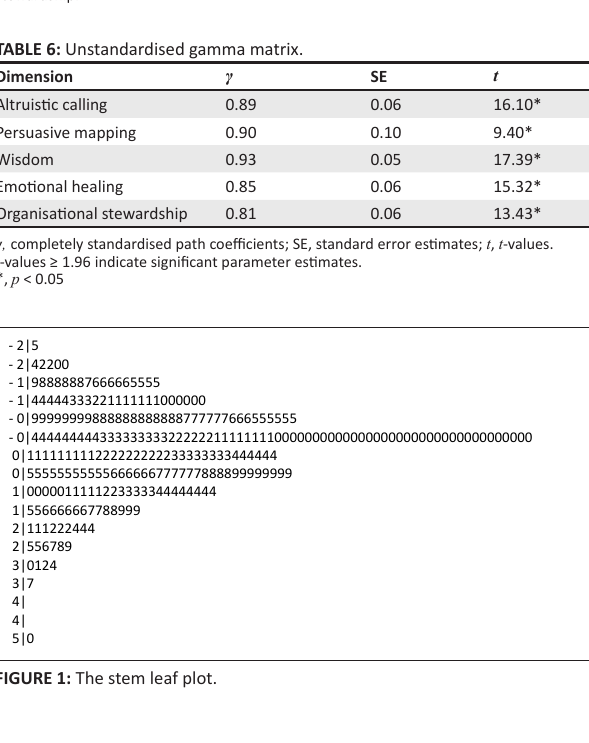
FIGURE 1: The stem leaf plot.